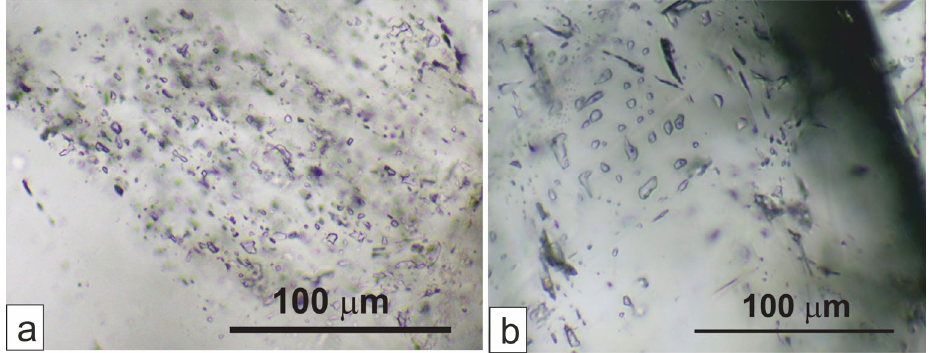
Figure 11. ( a ): Single ‐ phase primary inclusions of the H 2 O type in the quartz from the synchysite ‐ bearing vein. ( b ): Two ‐ phase pseudosecondary fluid inclusions of the H 2 O type in the calcite I from the synchysite ‐ bearing vein.